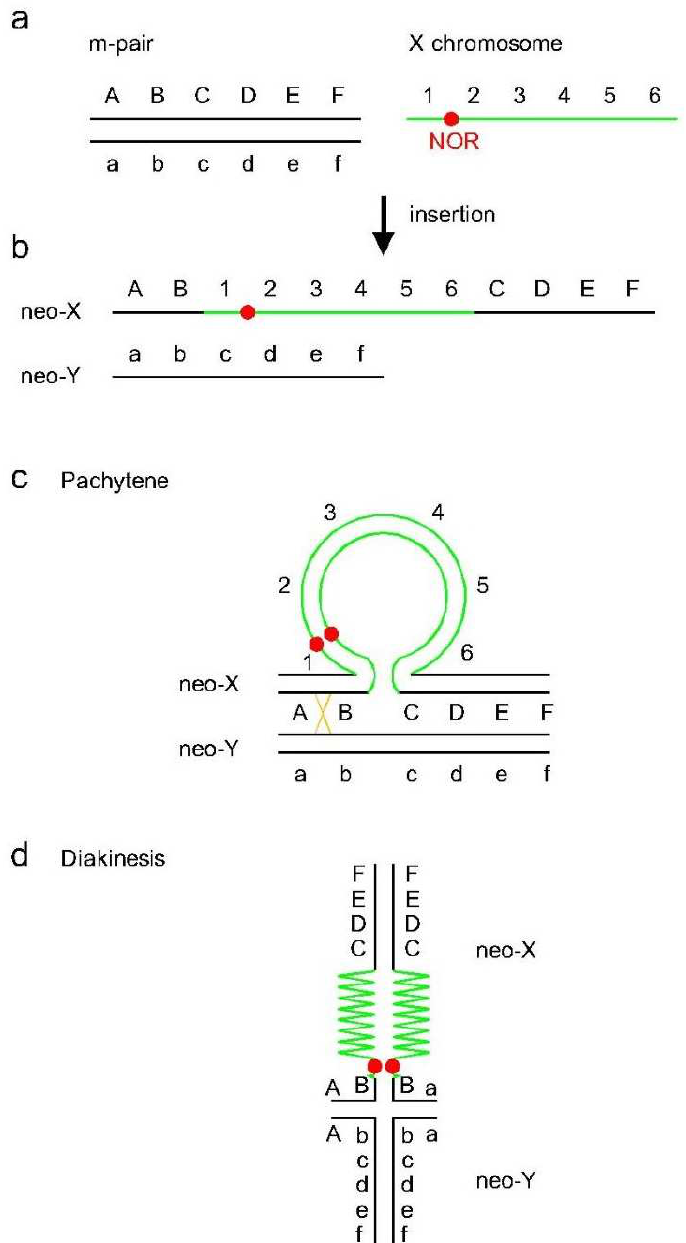
Figure 4. Schematic interpretation of chromosomal rearrangements in the evolution of neo-X and neo-Y chromosomes and meiotic configurations in Rhionaeschna planaltica . ( a ) Autosomal m-chromosome pair (black) and single X chromosome (green) with subterminal rDNA cluster, i.e., NOR (red). ( b ) Insertion of the X chromosome into one-third of one m-chromosome (neo-X). The NOR is located in the region of the X chromosome that was connected to the smaller part of the m-chromosome. ( c ) Pachytene pairing of the neo-XY bivalent with a crossing-over (orange) in the smaller pairing segment. ( d ) Heteromorphic sex chromosome bivalent in diakinesis with NOR near the chiasma. The fact that the rDNA repeats are located on an autosomal pair in the other species studied suggests that during the evolution of the chromosome complement of R. planal- tica , the rDNA was transposed from an autosome to the X chromosome by, for example, transposons or unequal crossing-over. In the next step, the other autosomal NOR was lost